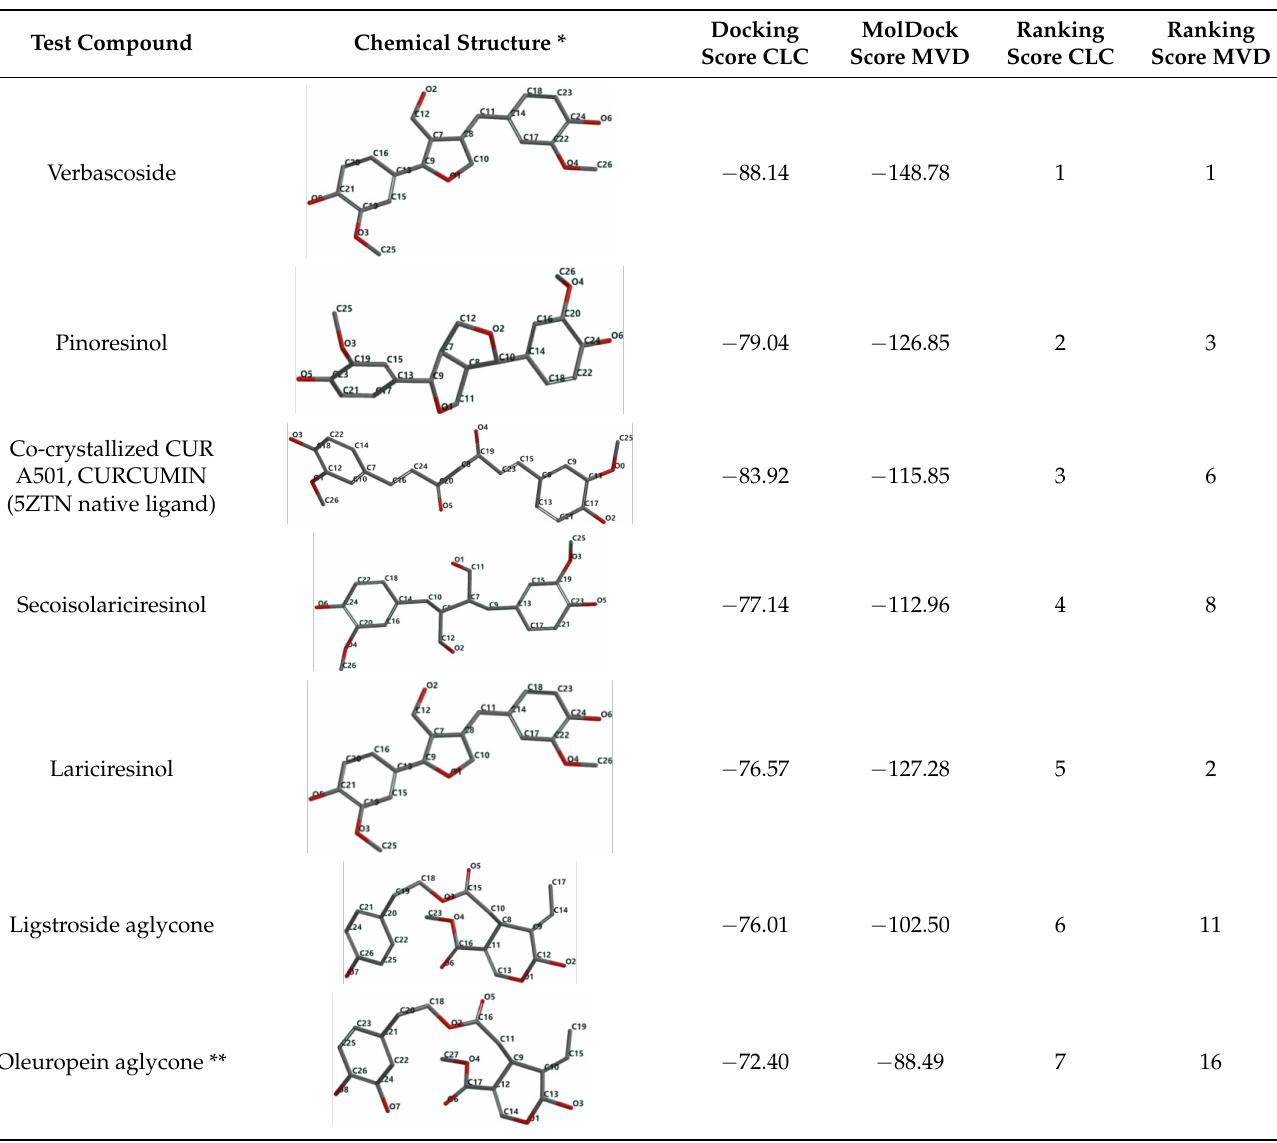
Table 1. The chemical structures and the strength of the interactions between the 20 test molecules docked into 5ZTN (by CLC and MVD software,